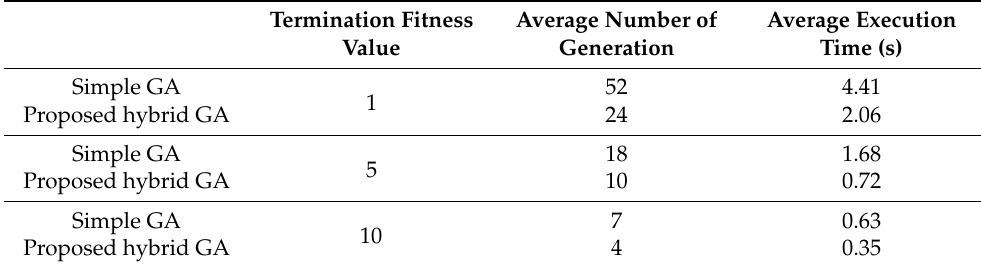
Table 4. Effect of termination value on the convergence speed of GA.